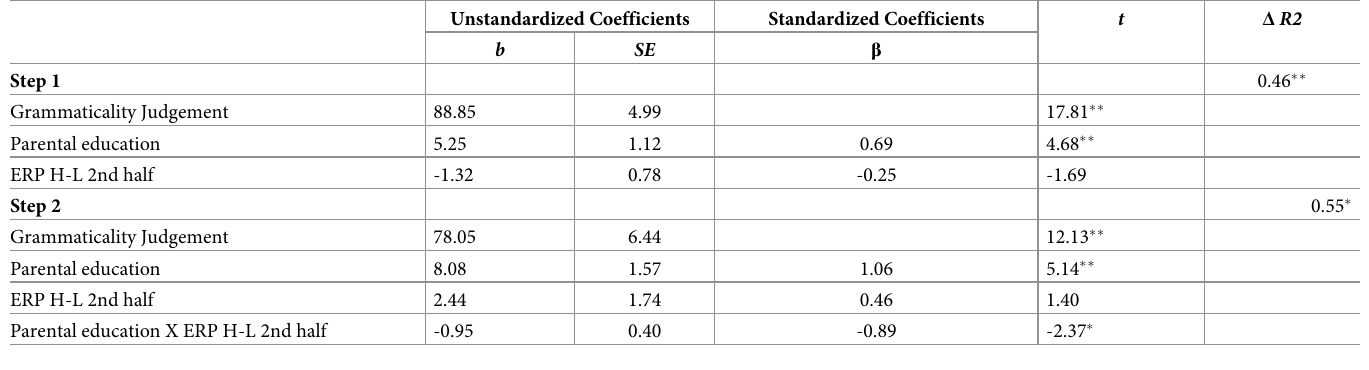
Table 4. Hierarchical regression analysis of the moderating effect of statistical learning (ERPs) on the relationship between parental education average and gram- maticality judgement